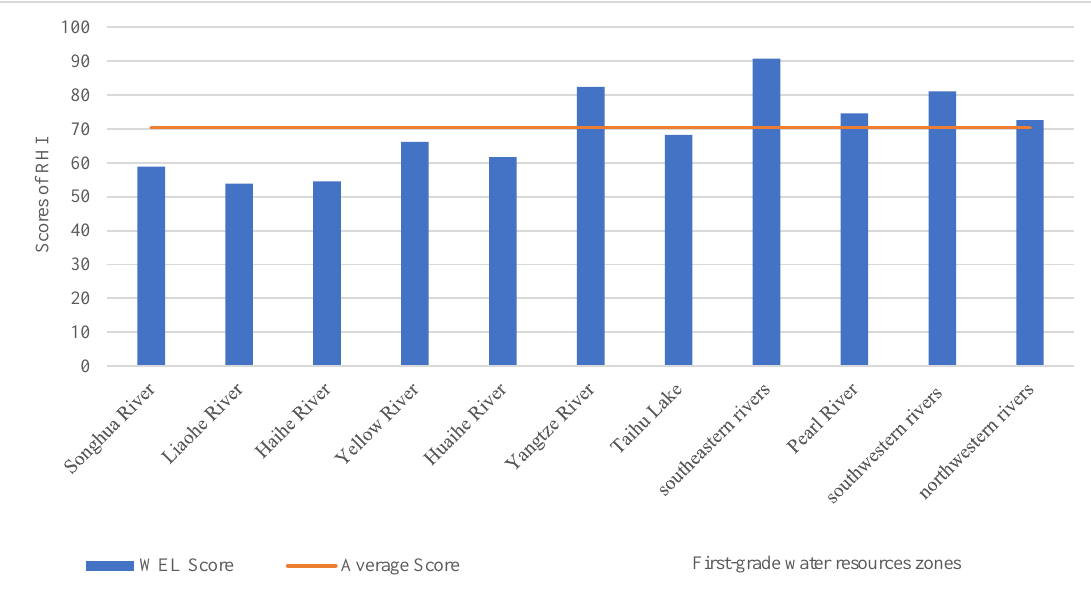
Figure 5. WEL evaluation results for China’s first -grade water resource zones.